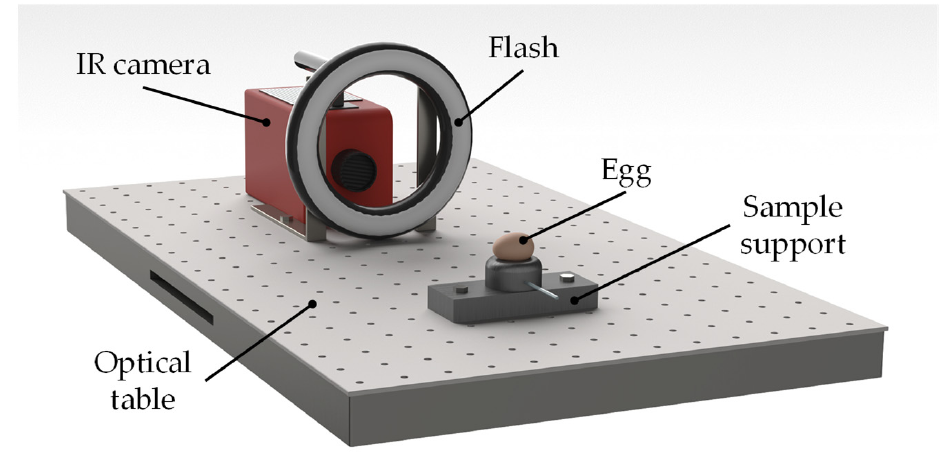
Figure 1. Schematic representation of the measuring principle of pulse phase thermography. bration grid was manufactured using an aluminum plate and machining a regular grid of circular slots. The circular slots had a 4 mm diameter and a center-to-centre pitch of 10 mm. The calibration grid was mounted in the same position of the egg and temperature and phase images were recorded (Figure 2). Image correction was applied using the proper function implemented in the National Instruments Vision Assistant